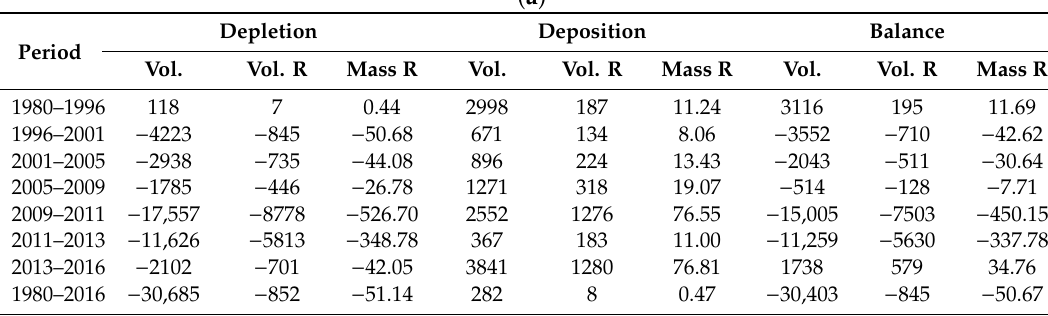
Table 9. ( a ) Depletion and deposition volumes and rates in detailed area for DSMs 1,2,3 . ( b ) Depletion and deposition volumes and rates in detailed area for edited DTMs 1,2,3